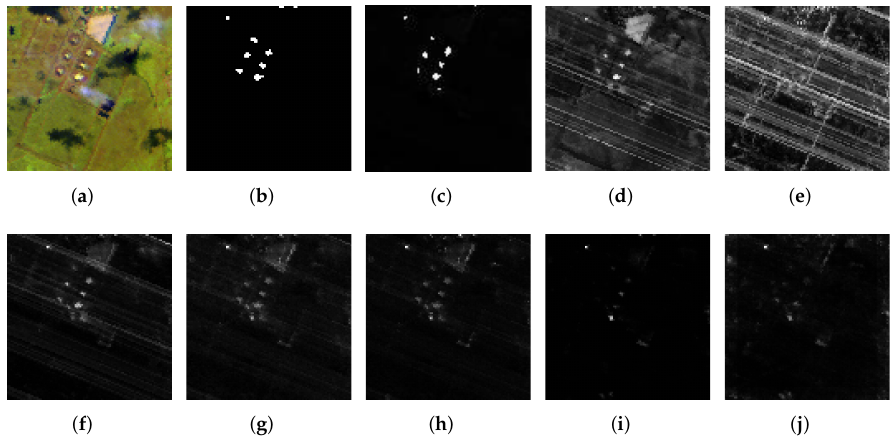
Figure 8. Visual detection results of all the algorithms on the TC-I dataset. ( a ) Pseudocolor image.